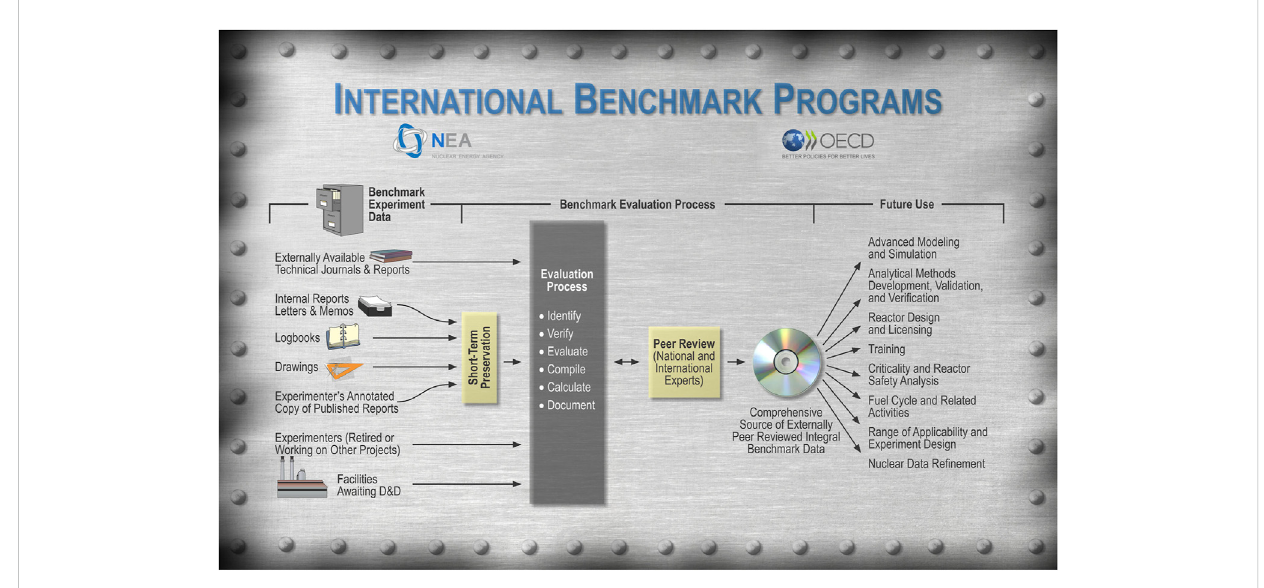
Overview of benchmark evaluation process for ICSBEP and